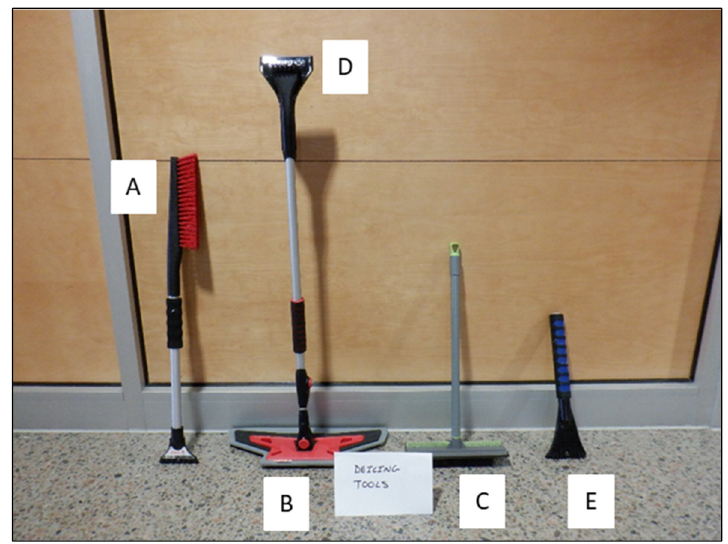
Figure 3. De-icing tools used in the multi-tools analysis, which range from softest to hardest: ( A ) the brush, ( B ) the flexible polymer blade, ( C ) the squeegee, ( D ) the hard polymer blade, and ( E ) the corrugated polymer blade.